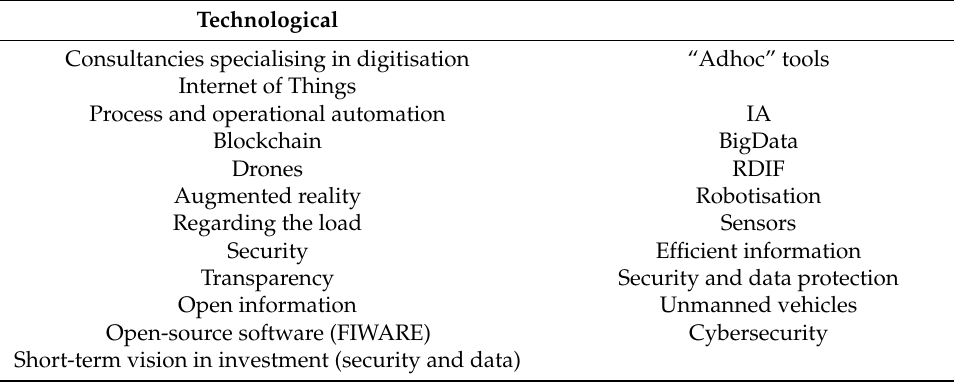
Table 4. Technological part of the BOT. Source: own elaboration.